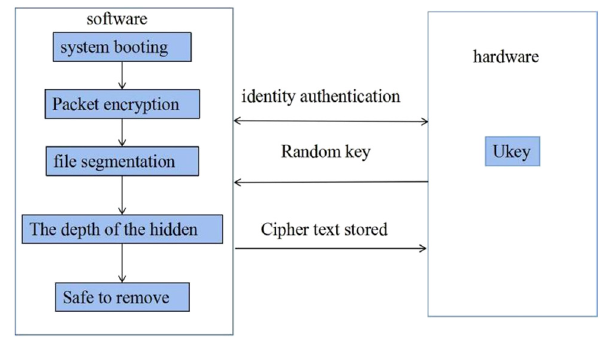
Figure 2: System overall